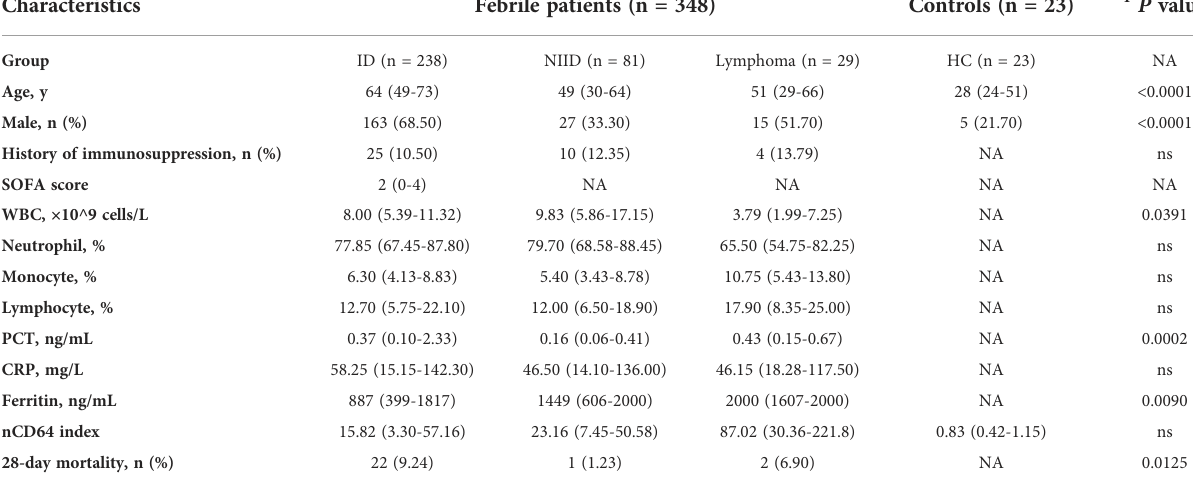
TABLE 1 Baseline characteristics of enrolled patients and